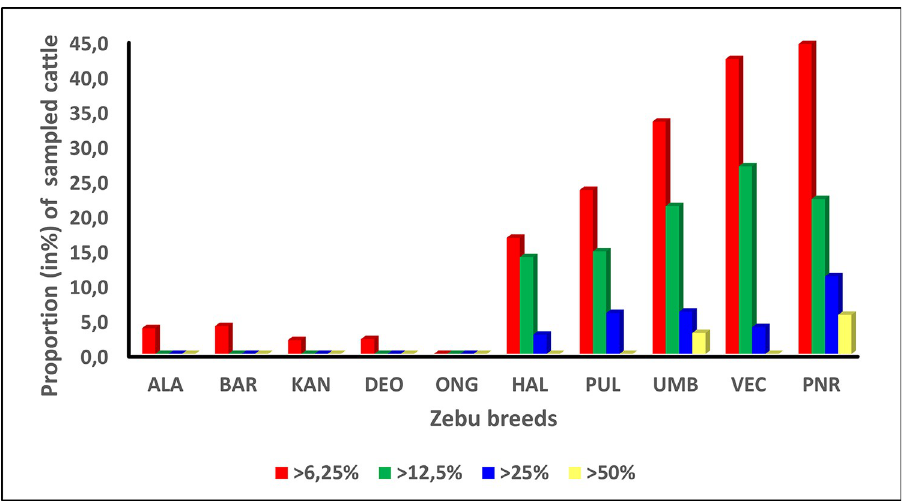
Fig 8. Proportion of sampled cattle (in %) with different levels of taurine admixture in South Indian zebu cattle breeds.